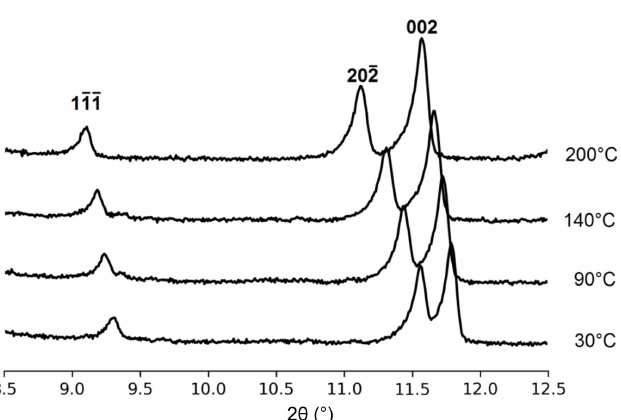
Figure 3 Typical PXRD pattern of 3 recorded at three different temperatures showing the shifts in selected peaks related to the thermal expansion.